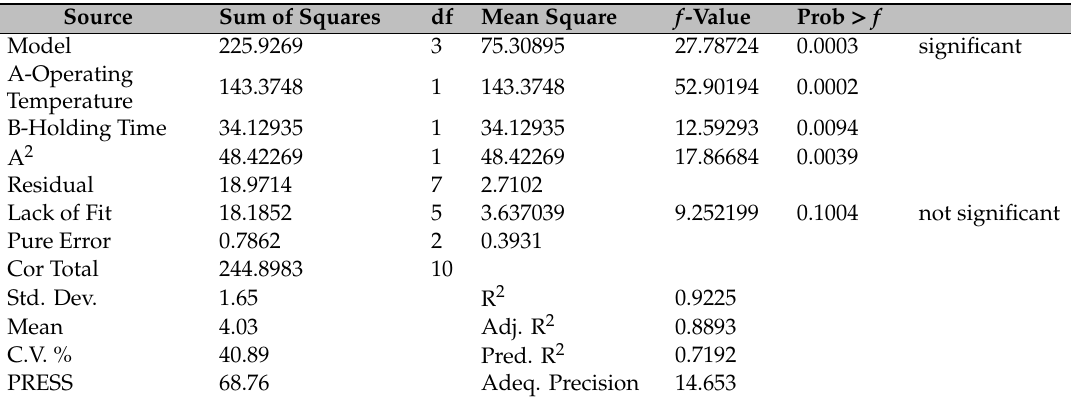
Table 10. ANOVA table for elongation to failure, ETF